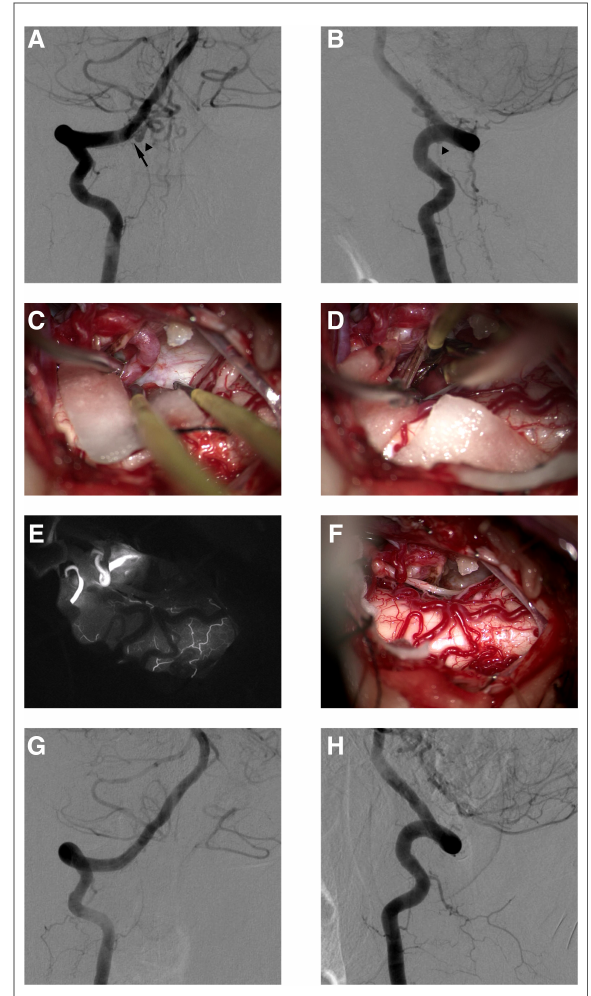
FIGURE 2 This female DAVF patient presented with VHM and was treated with microsurgery. Preoperative anteroposterior angiography of right VA ( A ). Preoperative lateral angiography of right RA ( B ). The AVF was fed by the right C-1 dural branch of VA (black arrow in A ), and the feeder drained into the intradural vein (black arrowheads in A,B ). The intraoperative image showed that the draining vein drains into the cephalic side ( C ). The intraoperative image showed that the draining vein was disconnected under the occlusion of the aneurysm clip ( D ). Intraoperative image ( E ) and indocyanine green angiography ( F ) in the same perspective showed the disconnection of the AVF. Postoperative anteroposterior angiography 4 days after microsurgery of right VA ( G ). Postoperative lateral angiography 4 days after microsurgery of right VA ( H